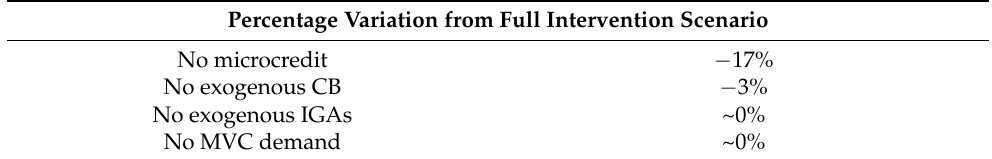
Figure 3. Effectiveness of listed scenarios. Each scenario is built by deactivating the effect of one complementary action. (MVC—Matembwe Village company; CB—capacity building; IGAs—income generating activities). Table 3. Quantitative results for different complementary activities, ranked with respect to